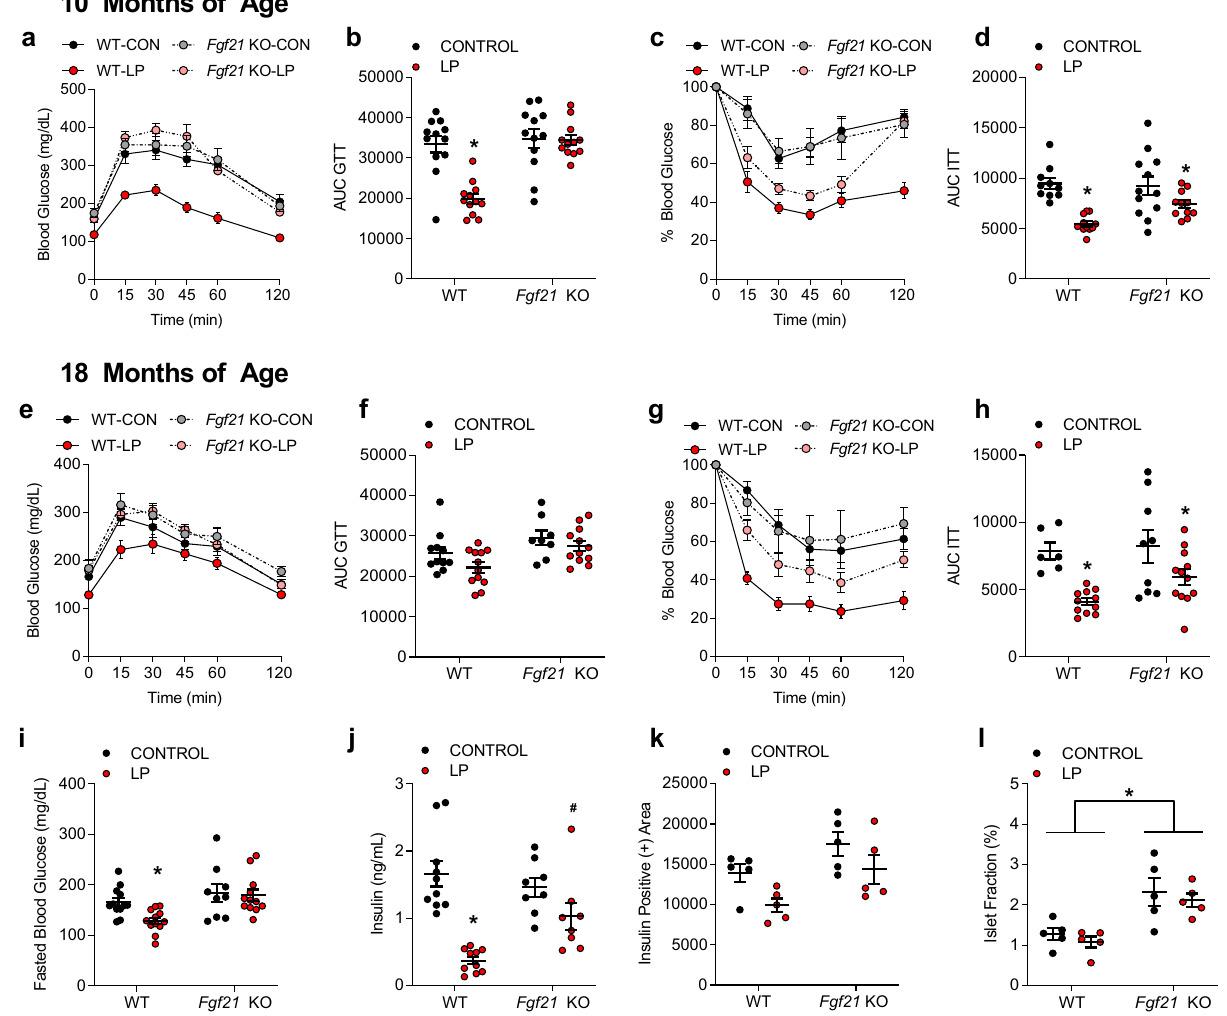
Fig. 4 FGF21 mediates low protein-induced improvements in glucose homeostasis in aged mice. a Glucose tolerance test measured at 10 months of age in WT and Fgf21 KO mice control or LP diets ( n = 8 – 12 mice/group, group*time p = 0.001). b Area under the curve glucose as measured in the GTT at 10 months of age ( n = 8 – 12 mice/group geno*diet p = 0.001). c Insulin tolerance test at 10 months of age ( n = 8 – 12 mice/group, group*time p = 0.001). d Area under the curve glucose as measured in the ITT at 10 months of age ( n = 8 – 12 mice/group; diet p = 0.001). e Glucose tolerance test measured at 18 months of age in WT and Fgf21 KO mice control or LP diets ( n = 8 – 12 mice/group group*time p = 0.236). f Area under the curve glucose as measured in the GTT at 18 months of age ( n = 8 – 12 mice/group) geno p = 0.004, diet p = 0.062. g Insulin tolerance test at 18 months of age ( n = 8 – 12 mice/group group*time p = 0.001). h Area under the curve glucose as measured in the ITT at 18 months of age ( n = 8 – 12 mice/group; diet p = 0.003). i Fasting blood glucose at 18 months of age ( n = 8 – 12 mice/group; diet p = 0.06, geno p = 0.0031, geno*diet p = 0.128). j Serum insulin levels at sacri fi ce at 22 months of age ( n = 8 – 12 mice/group; geno*diet p = 0.01). k Insulin positive area as measured via insulin IHC on fi xed pancreas collected at sacri fi ce at 22 months of age ( n = 5 mice/group; geno p = 0.001, diet p = 0.02). l Islet fractional percentage as measured on fi xed pancreas collected at sacri fi ce at 22 months of age ( n = 5 mice/group; geno p = 0.01). Statistical analyses were conducted using one or two-way ANOVA. All values are mean ± SEM, with signi fi cant posthoc comparison within the diet*genotype interaction noted as * p < 0.05, # p < 0.10 compared with respective control. Source data are provided as a Source Data fi